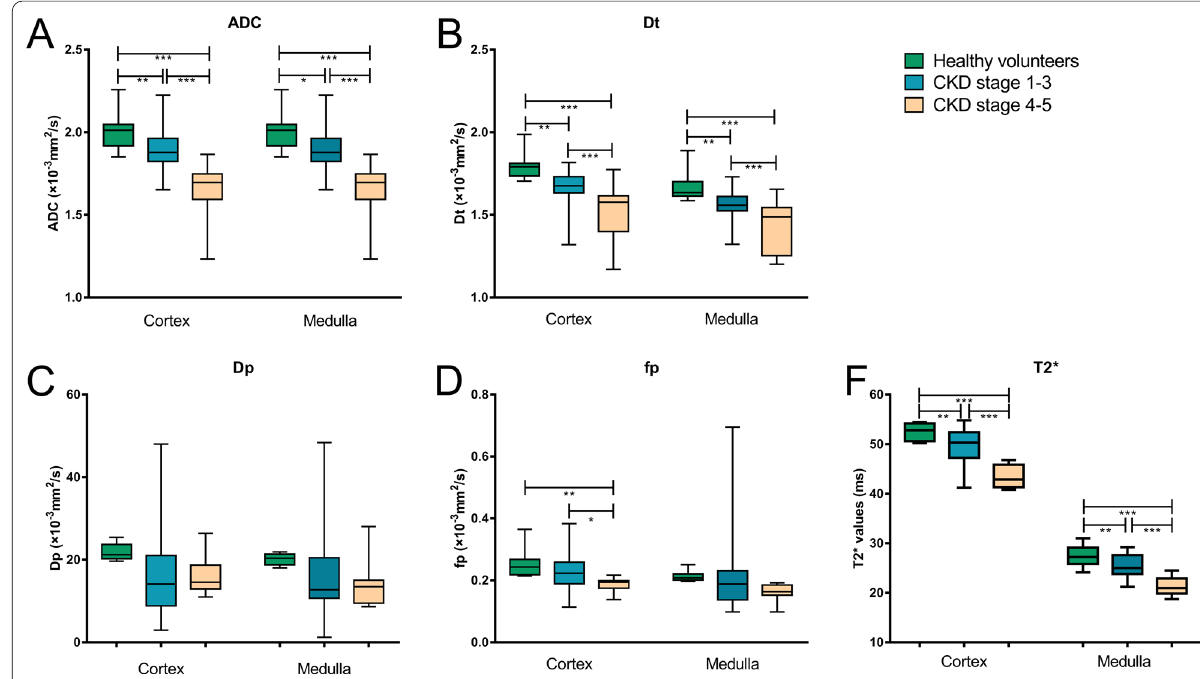
Fig. 5 Comparison of MRI-derived parameters between healthy volunteers, CKD stage 1–3 and CKD stage